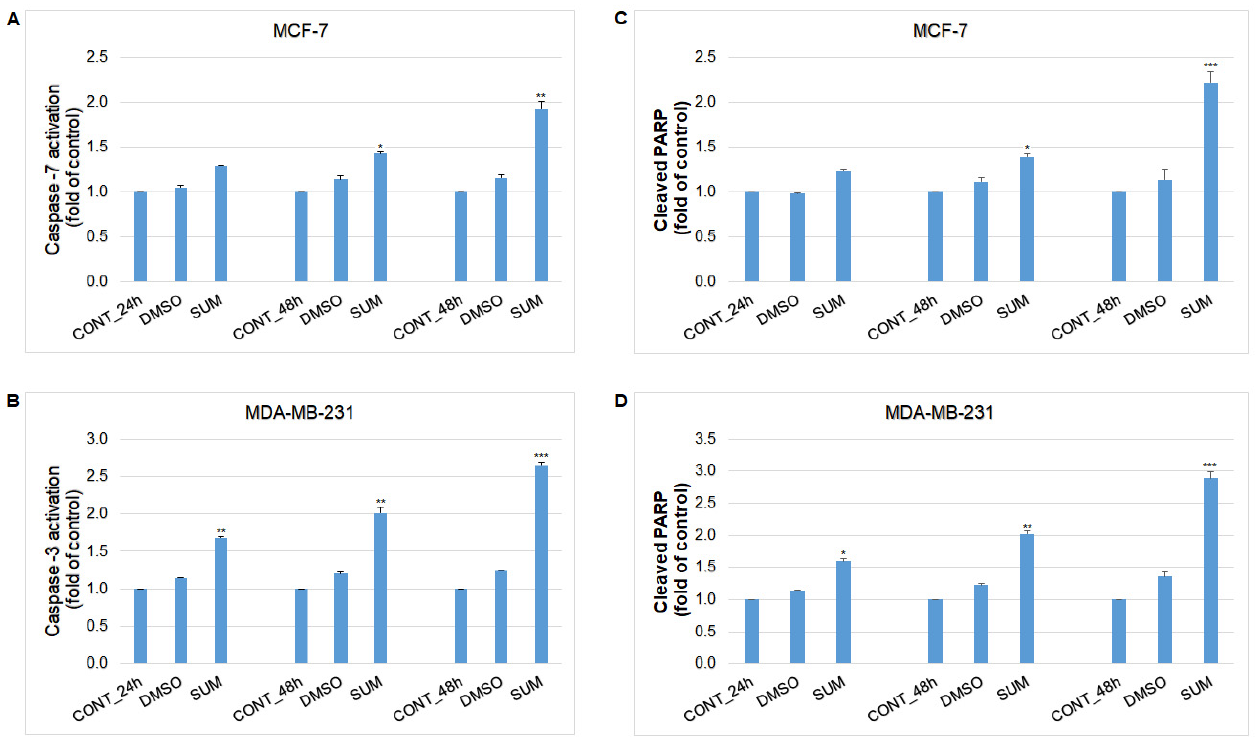
Figure 14. Effect of SUM treatment (155 or 215 µg/mL) on: ( A ) caspase-7 (MCF-7), ( B ) caspase-3 activation (MDA-MB-231), and PARP cleavage in both cell lines ( C , D ) analyzed by flow cytometry. Data were obtained from three independent experiments and significant differences were marked as * p < 0.05, ** p < 0.01, *** p < 0.001, versus control cells (untreated).